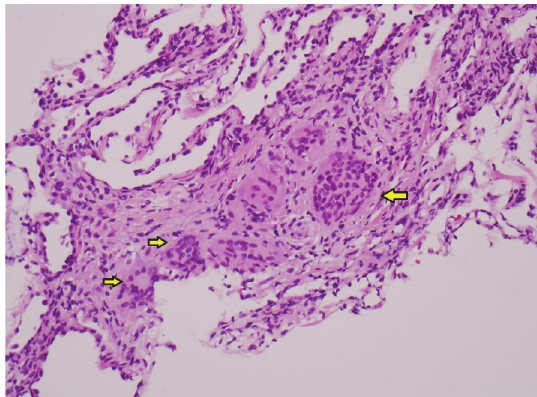
Figure 2: Hematoxylin and eosin staining (200x) of right lower lobe transbronchial biopsy showing nonnecrotizing granulomas